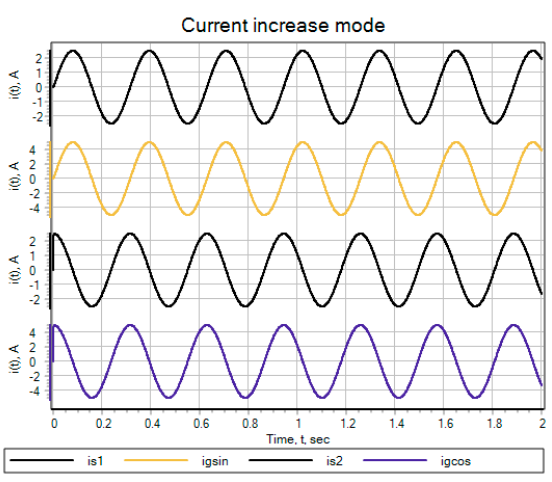
Figure 16. Load current and voltage in series parallel connection of the stator windings.